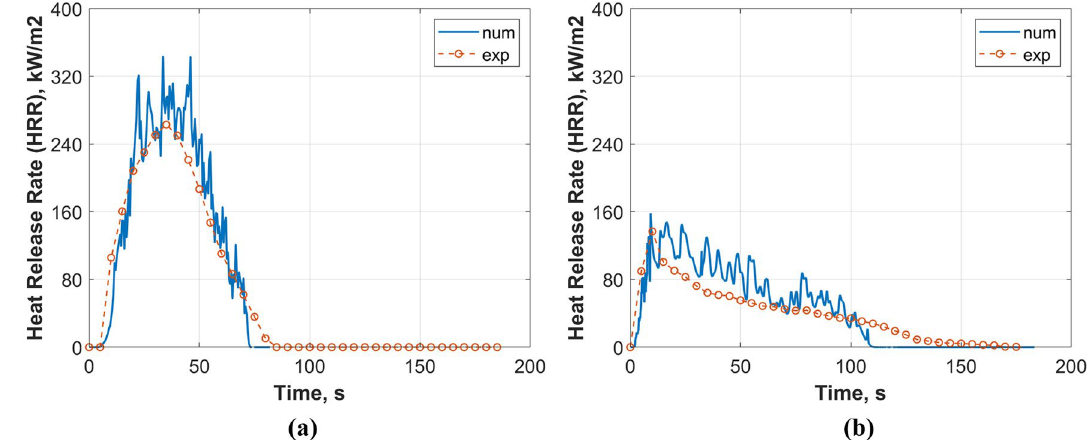
Figure 8. Experimental and numerical HRR from the cone calorimeter for ( a ) pure PUF and ( b ) [CH/PA/ 2 Ti 3 C 2 ] 3 PUF under a heat flux of 35 kW/m